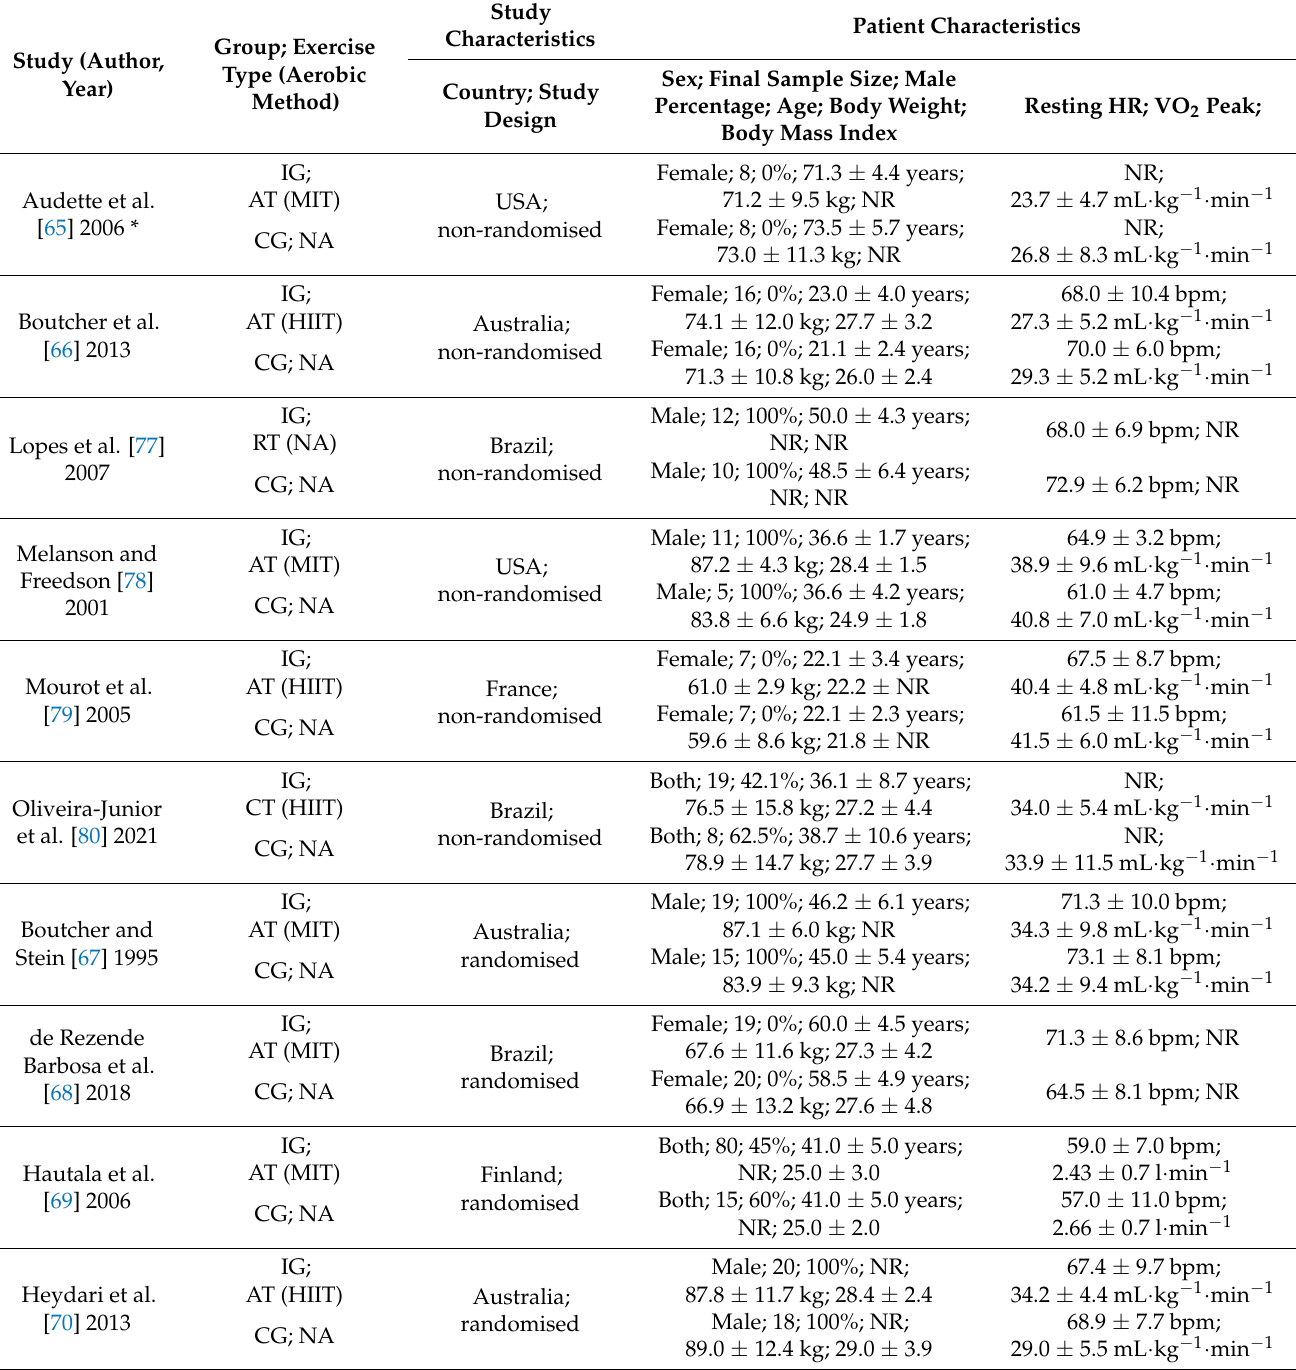
Table 1. Study and participant